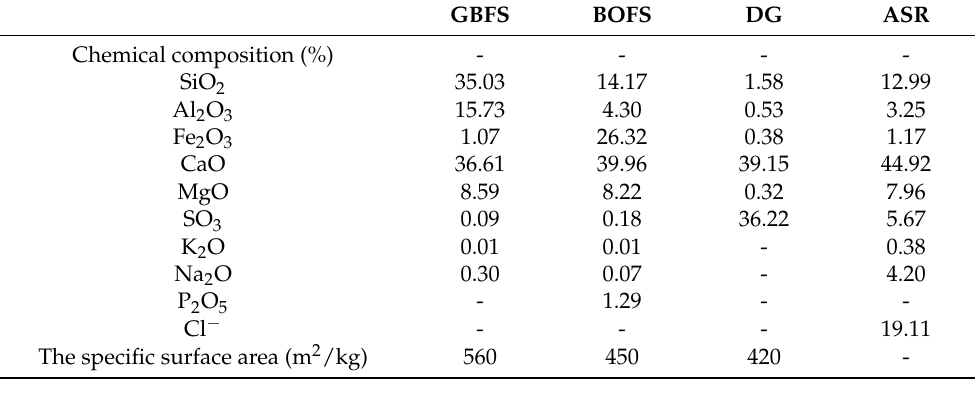
Table 1. Chemical composition and specific surface area of raw materials.